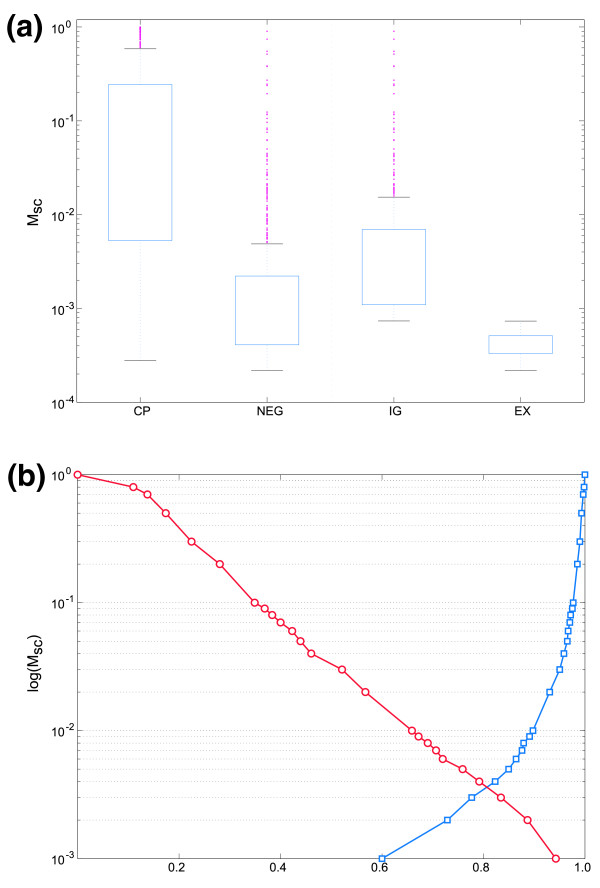
MAPP score distributions. (a) The distribution of MAPP scores (Msc) for core promoter (CP) and negative (NEG) sequences are given for the test dataset Test1. Upper and lower limits of the box represent the upper and lower quartiles of the distribution, respectively. Whiskers extending from the boxes represent the extent of the rest of the data distribution, while outliers are represented by magenta points. On the right-hand side of the dotted line is the breakdown of the NEG distribution into separate distributions for intergenic (IG) and exonic (EX) sequences. (b) The specificity (blue squares) and sensitivity (red circles) at different Msc thresholds.